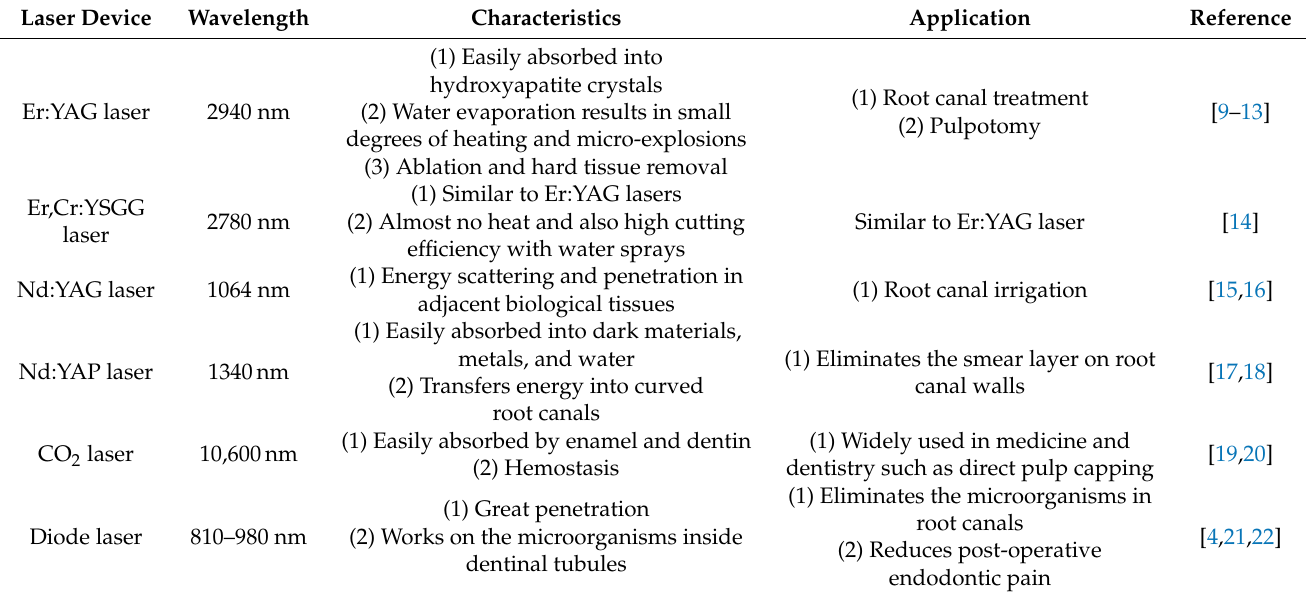
Table 1. Lasers in